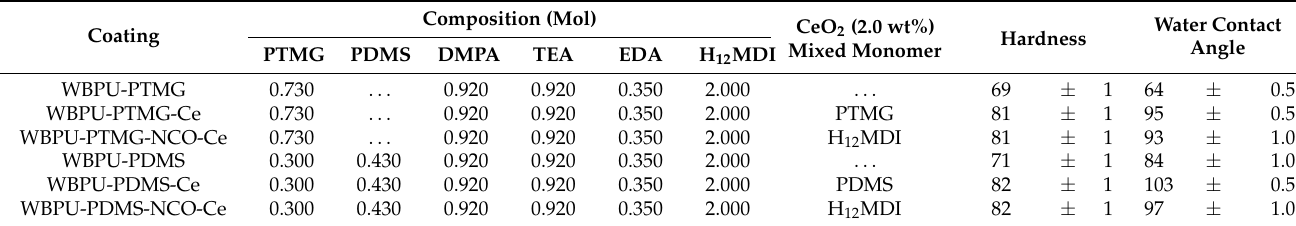
Table 1. Sample designation and composition of